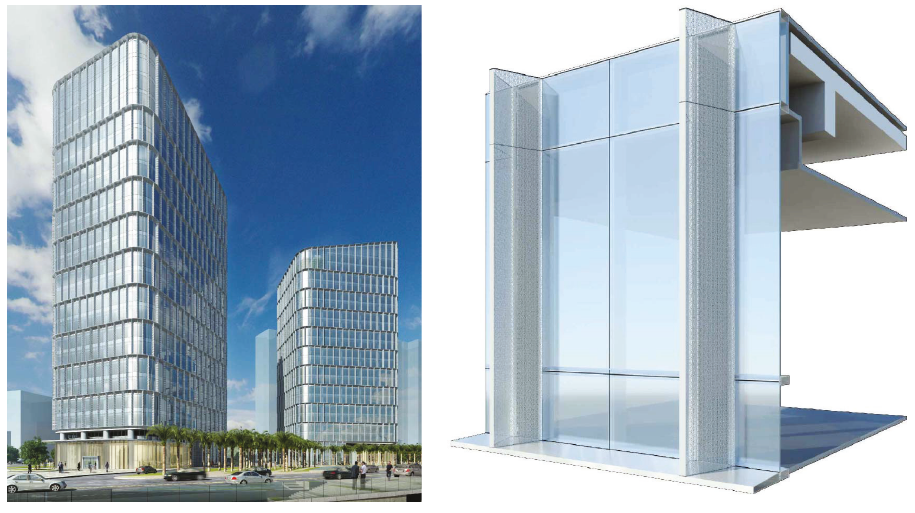
Figure 1: Curtain wall system with shading devices for energy conservation in high-rise